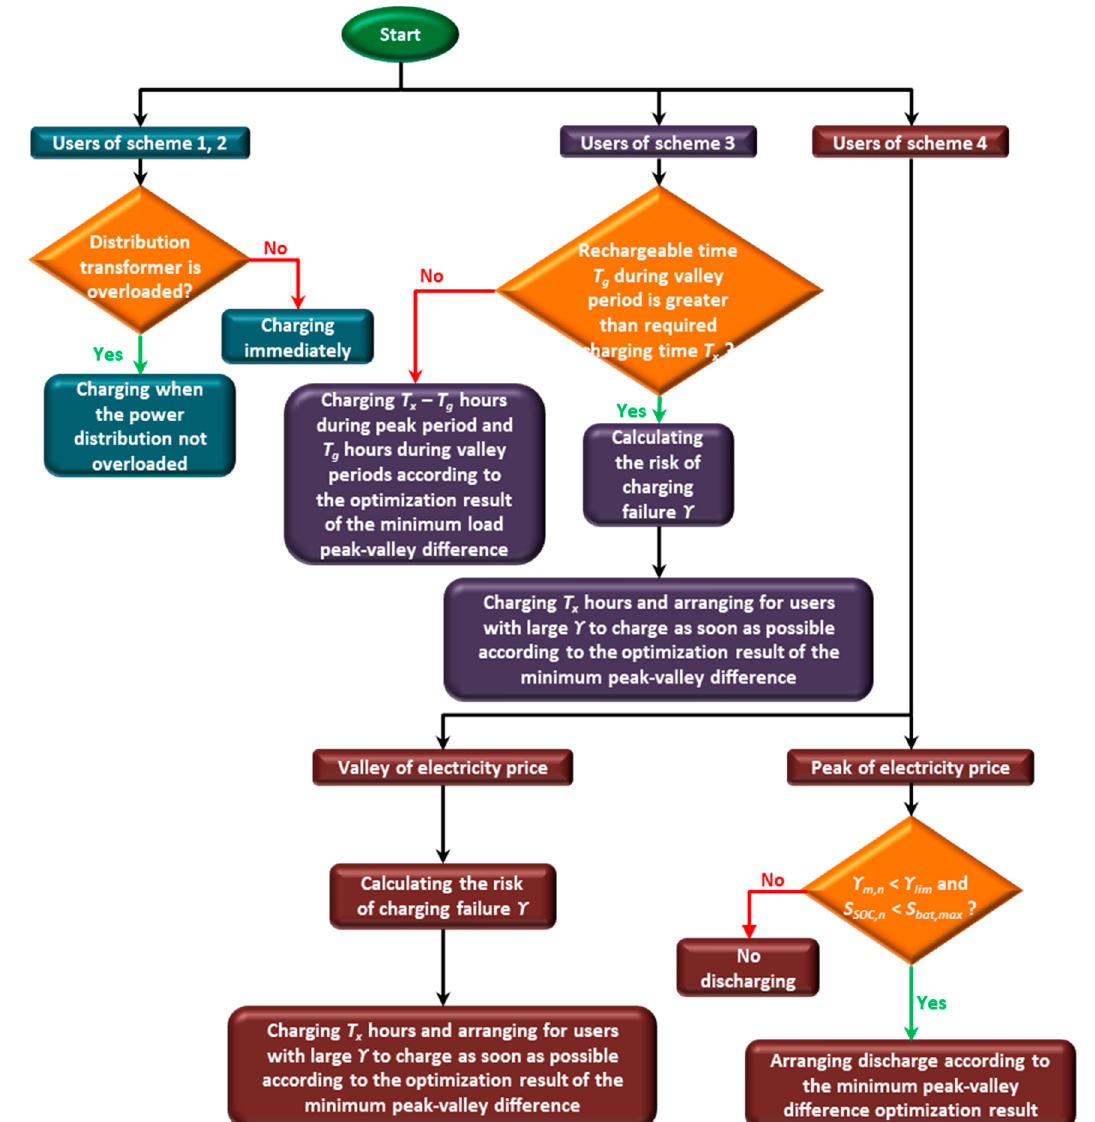
Figure 8. Orderly charge and discharge control process in EV